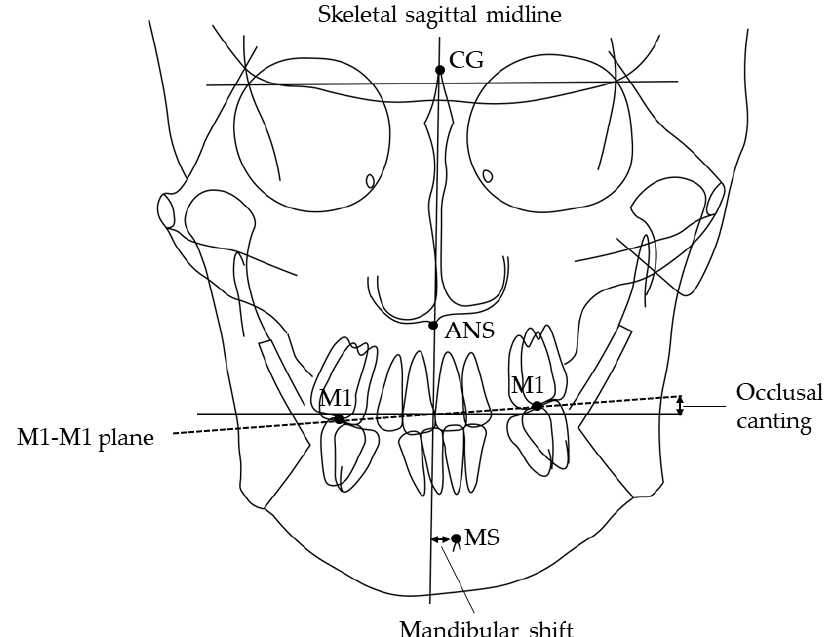
Figure 1. Landmarks and planes used in the cephalometric analysis. MS, mental spine; CG crista galli; ANS, anterior nasal spine. Skeletal sagittal midline, the plane from CG through the ANS; M1-M1 plane, the maxillary intermolar plane; Shift, deviation of MS to the skeletal sagittal midline in the postero-anterior cephalometric radiograph. Occlusal canting, the angle of the M1-M1 plane and the line perpendicular to the skeletal sagittal midline in the postero-anterior cephalometric